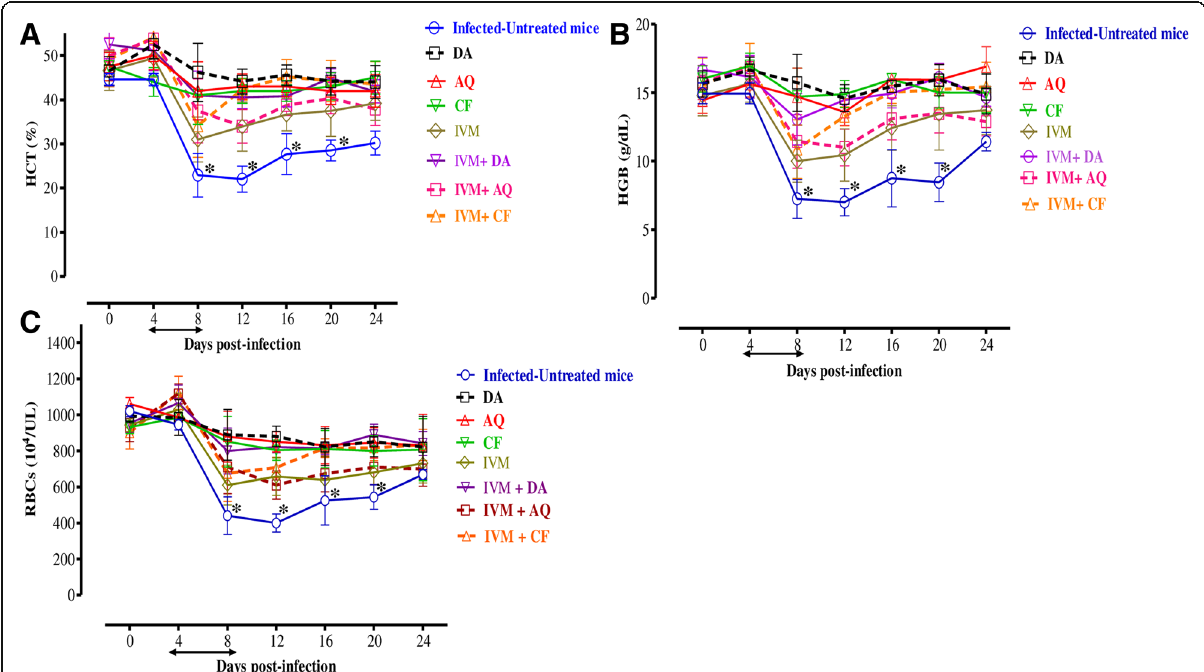
Fig. 5 Changes in the hematocrit count ( a ), hemoglobin percentage ( b ), and red blood cell count ( c ) in IVM-treated mice in vivo. The graphs show changes in the hematocrit count ( a ), hemoglobin percentage ( b ), and red blood cell count ( c ) of mice treated as compared with untreated mice. The different groups used were DA-IP, AQ-oral, CF-oral, IVM-IP, IVM-DA, IVM-AQ, IVM-CF, and untreated mice. The values plotted are the mean ± standard deviation for two separate trials. Each group contained five mice. Asterisks (*) indicate statistical significance ( p < 0.05) based on one-way ANOVA Tukey ’ s test using GraphPad Prism version 5.0 for Windows (GraphPad Software Inc., San Diego, CA, USA). The arrow indicates